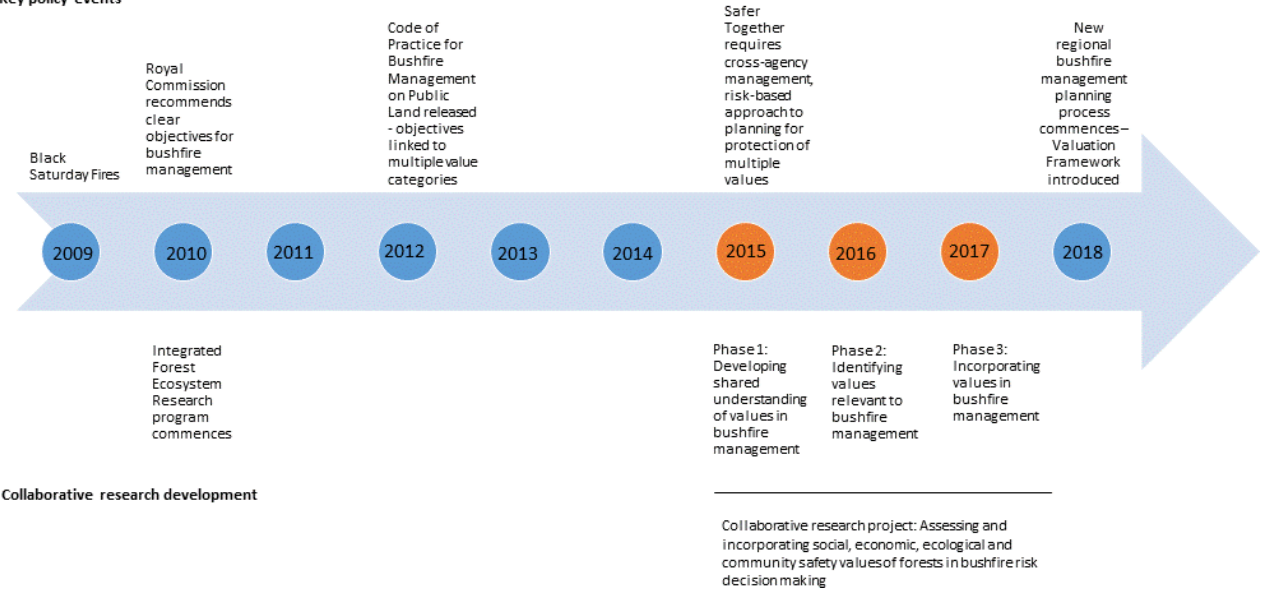
Fig. 3. Timeline of key events relating to bushfire management governance adaptation, Victoria 2009–2018, in relation to phases of the collaborative research